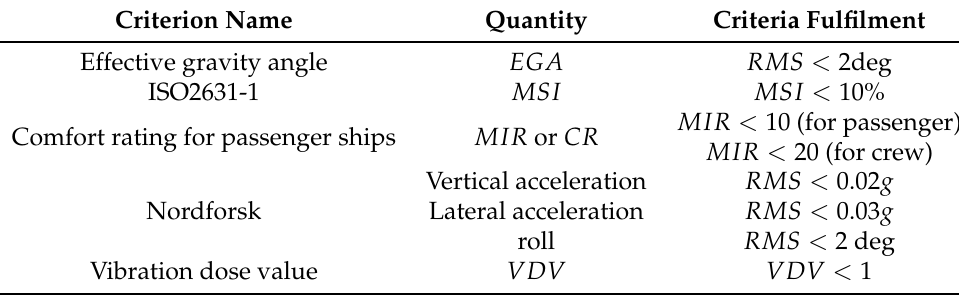
Table 1. Comfort-related ship motion criteria applicable for passenger